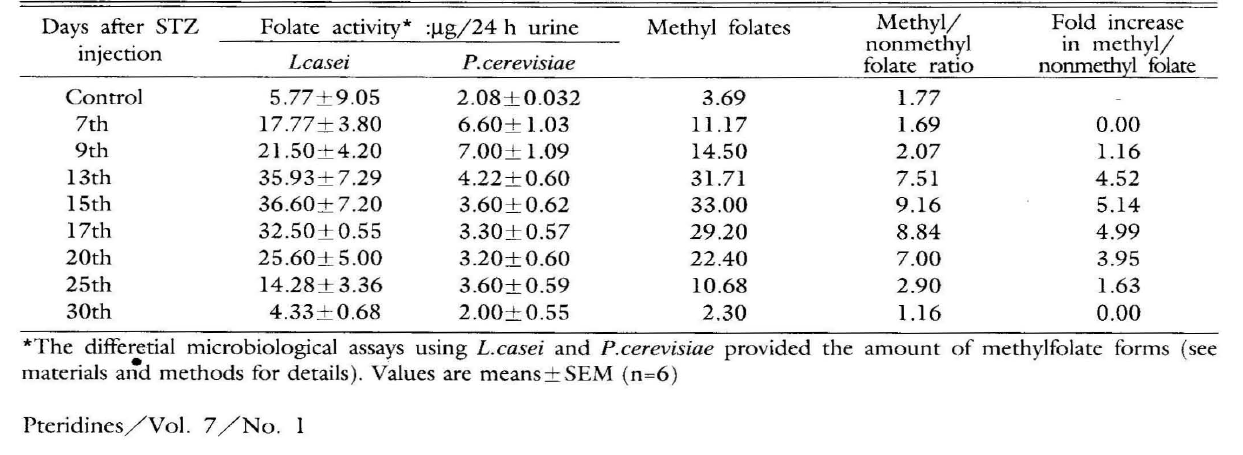
Table 3. Increased urinary excretion of methyltetrahydrofolates at various days of diabetes in rats Days after